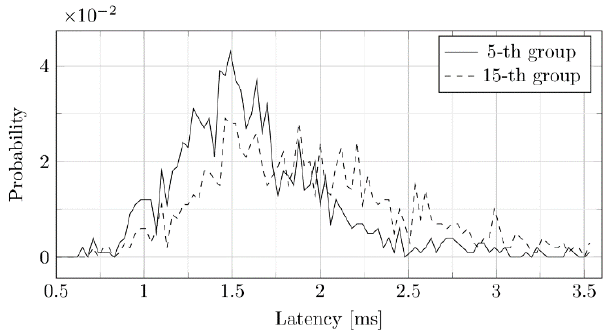
Figure 16. Probability density functions for latency values measured in the fifth and 15th groups of one thousand operations.